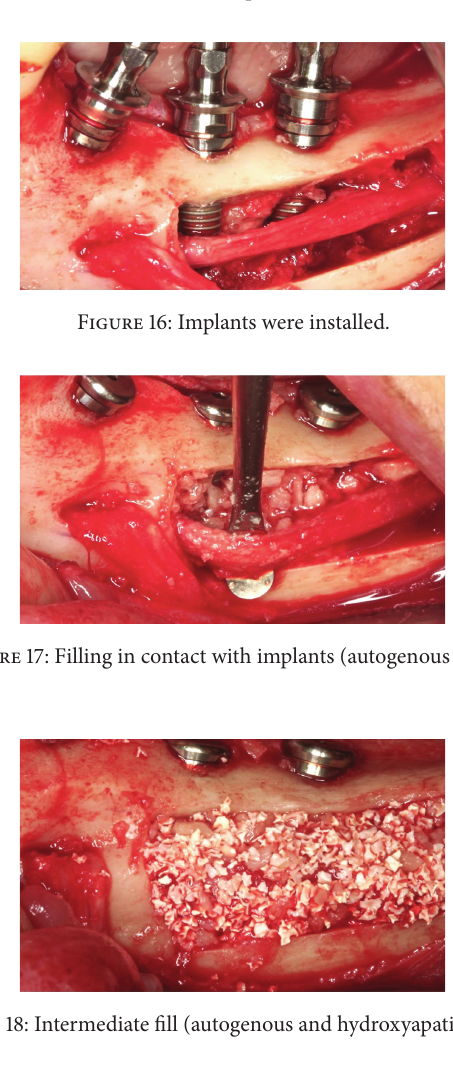
Figure 15: Traction beam performed with a Freer.